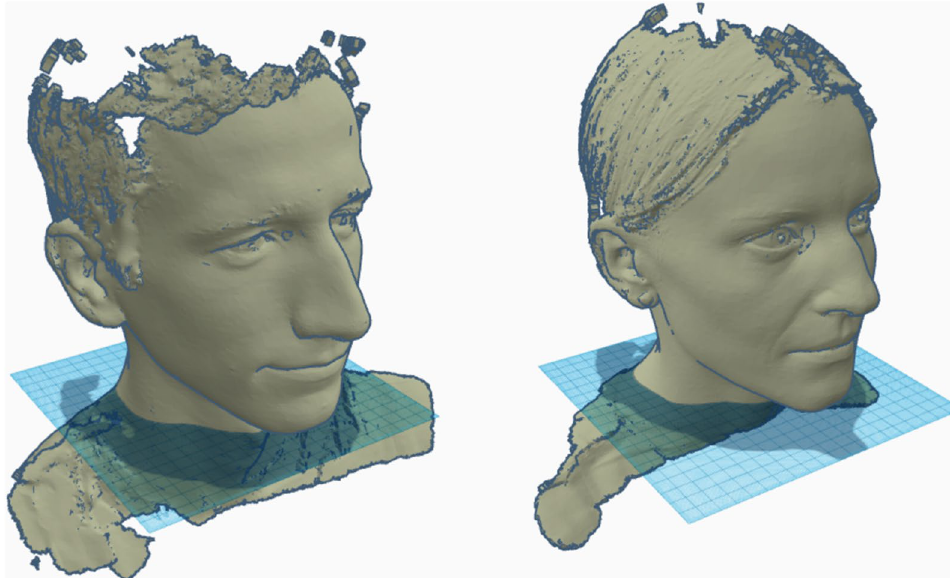
Figure 2. Two of the 12 face scans used to create seal performance test faces.